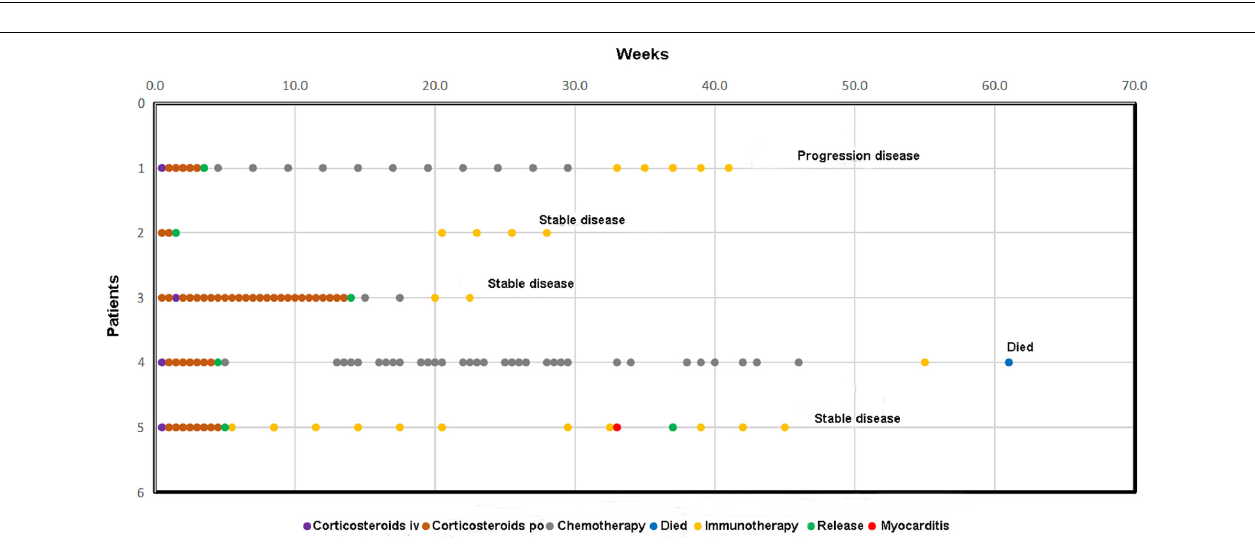
reports of thymoma patients with ICI-related